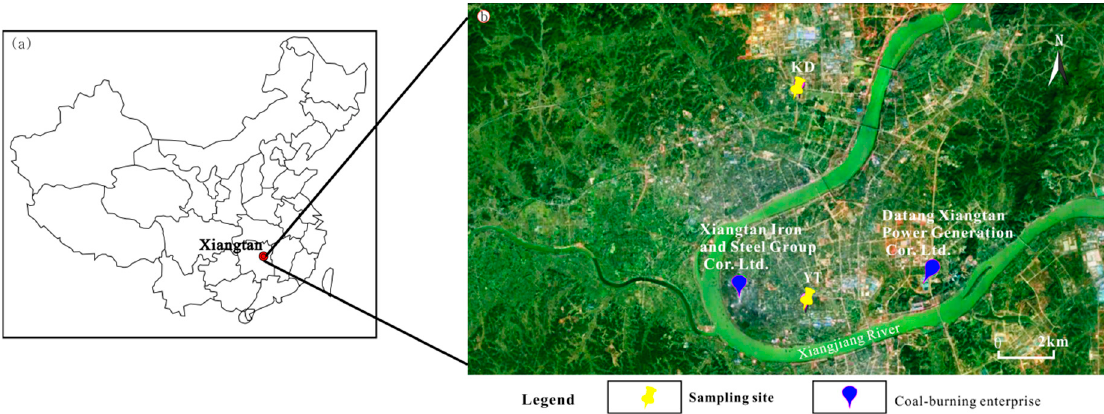
Figure 1. Location map of Xiangtan City ( a ) and satellite image showing the two sampling sites ( b ).